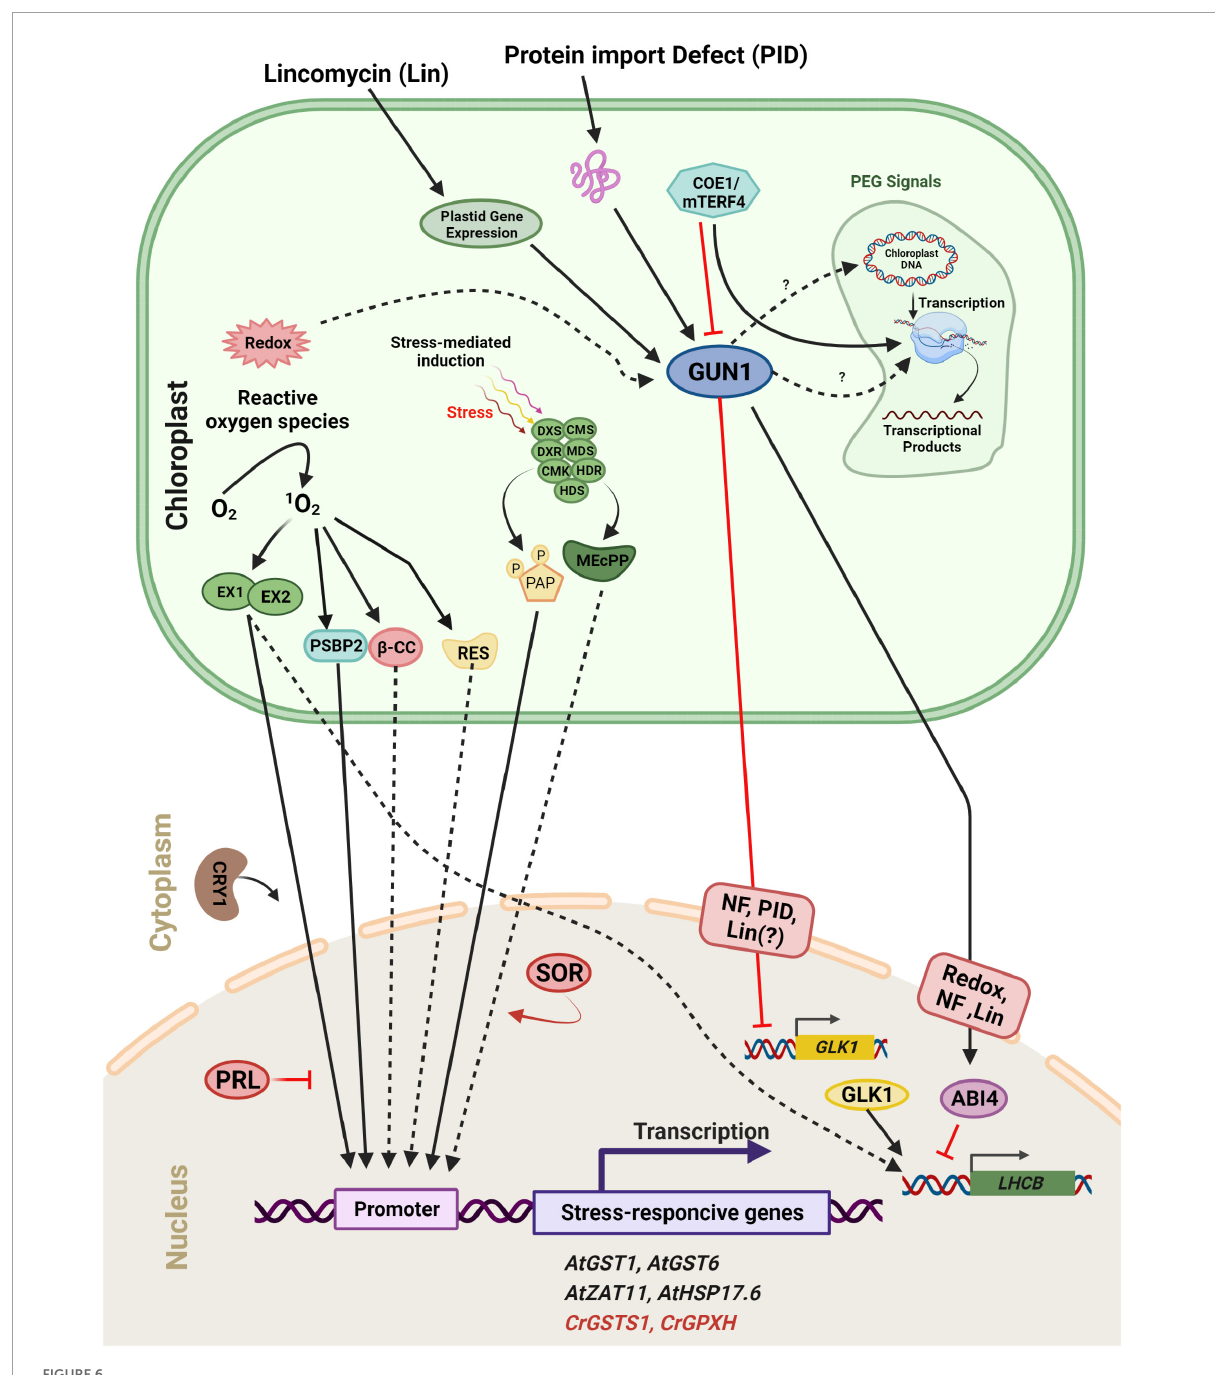
FIGURE6 Scheme of plastid retrograde signaling (PGE) in a plant/algal cell. Components are considered to be involved in 1 O 2 -mediated induction of either Arabidopsis thaliana ( At , black) or Chlamydomonas reinhardtii ( Cr, Red) genes. 1 O 2 accumulates during exposure to excess light and activates distinct signaling pathways. The 1 O 2 accumulated in the plastid is sensed and/or transmitted to the nucleus via the concerted action of two chloroplast proteins, EXECUTER 1 and EXECUTER 2 (EX1 and EX2). In the cytosol/nucleus, the blue-light photoreceptor CRY1 is involved in 1 O 2 -mediated stress responses, but PRL may act as a general negative regulator of 1 O 2 signaling. One product of the 1 O 2 -caused oxidation of carotenoids, β -cyclocitral ( β -CC), may act as a second messenger involved in the 1 O 2 signaling pathway in plants. A second stress response involves the induction of methylerythritolcyclo diphosphate (MEcPP) and phosphoadenosine phosphate (PAP), two important metabolites that participate in retrograde signaling through chromatin remodeling and changes in nuclear gene expression. Full arrows indicate activation or conversion, and dashed arrows indicate diffusion or transport of molecules. Furthermore, distinct plastid processes [redox change, plastid gene repression by Lincomycin (Lin), Norflurazon (NF), and Protein Import Defect (PID)] generate plastid signals. These signals converge at GUN1 within the plastid. Subsequently, the signal is sent to two transcription factors, ABI4 and GLK1. GUN1 activates ABI4, a negative regulator of LHCB expression and also down-regulates the expression of GLK1 , leading to a subsequent decrease in LHCB